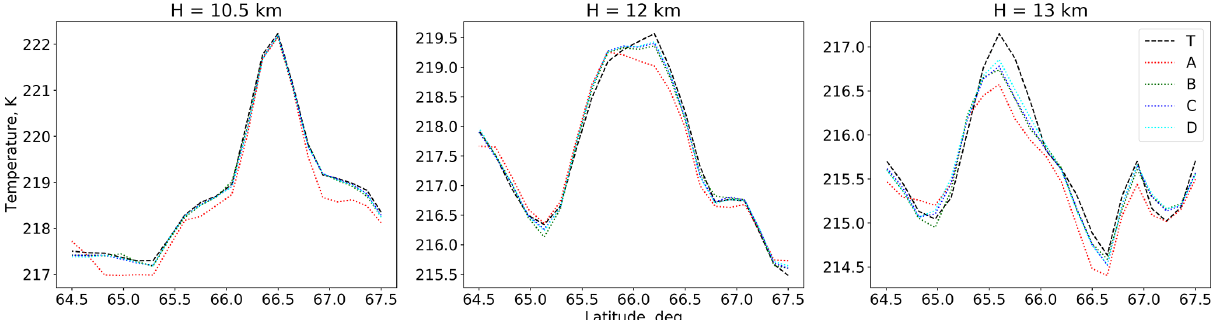
Figure 4. Retrieved temperature at different altitudes in the vertical cut shown in Figs. 1 and 3. Line T represents the true temperature of the simulated atmosphere, A–D are the respective retrievals.